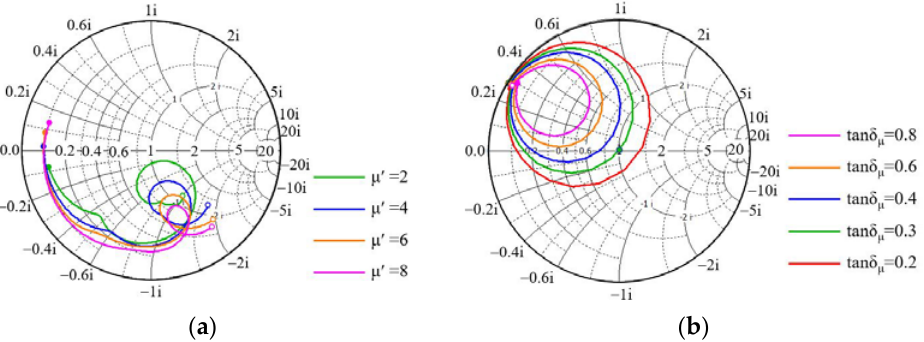
Figure 6. The effect of permeability on matching characteristics of the proposed absorber; ( a ) is the real part in Ku-band and ( b ) is the magnetic loss in L-band.